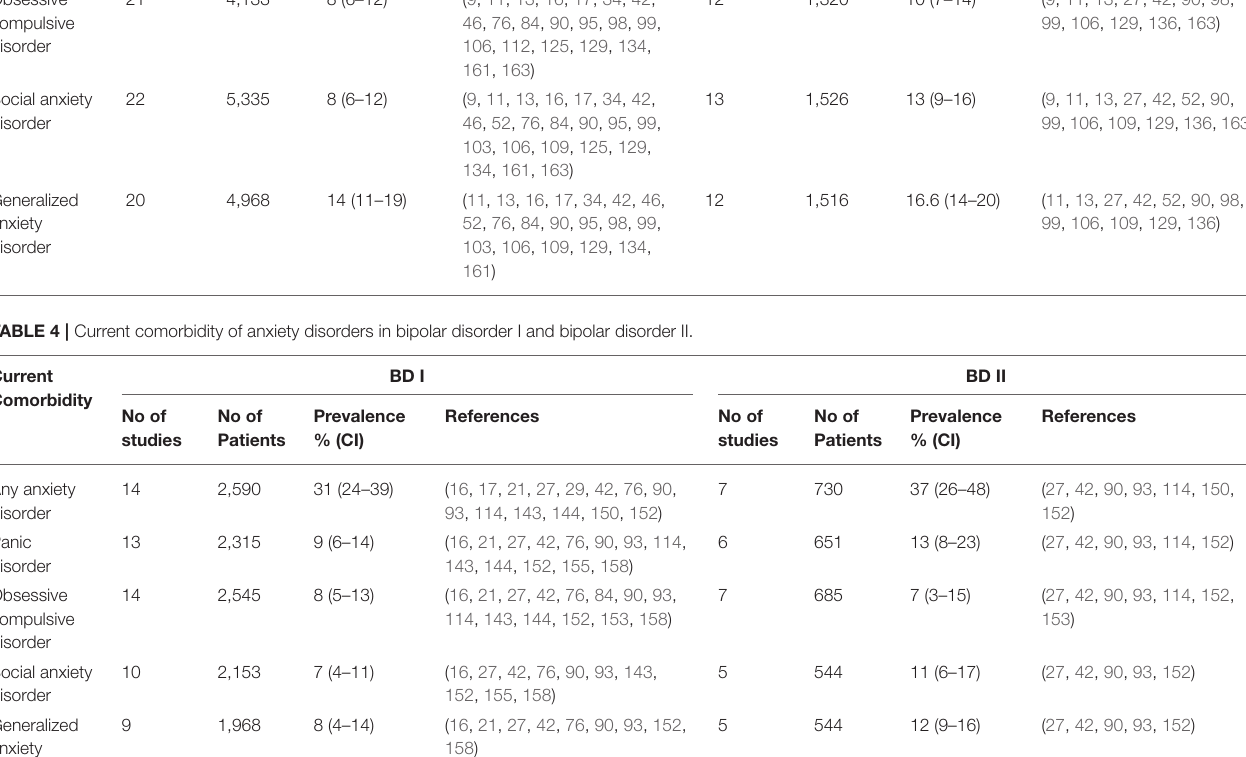
TABLE 3 | Lifetime comorbidity of anxiety disorders in bipolar disorder I and bipolar disorder II. Lifetime Comorbidity